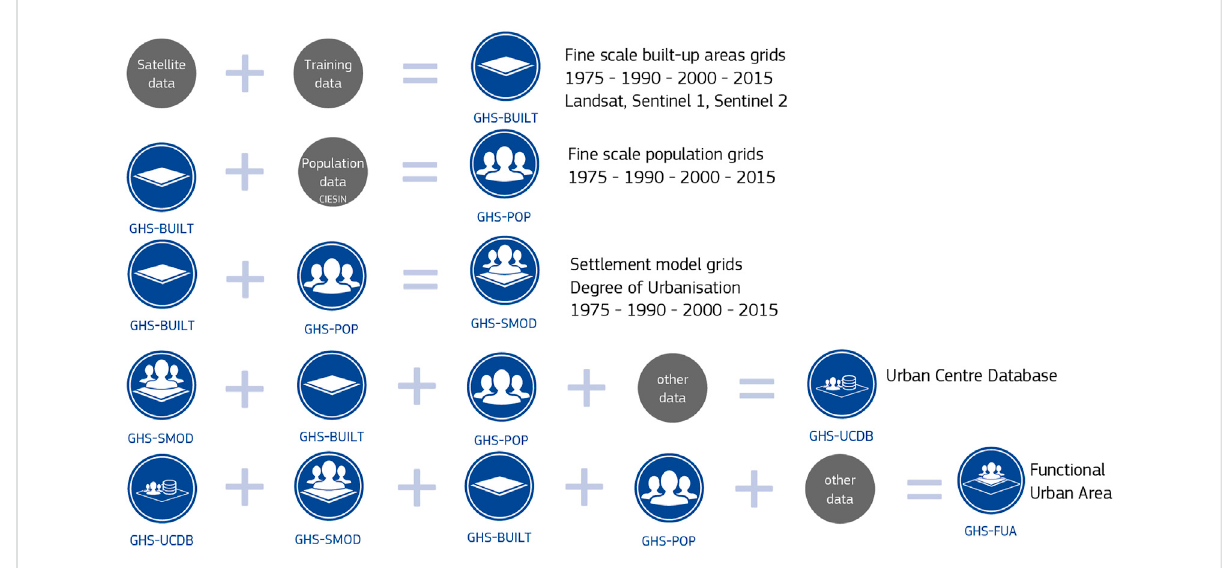
FIGURE 6 Hierarchicalanatomyofthekeyinformationcomponentsanddataprocessing/integrationusedtocreatetheGHS-UCDB.Startingfromsatellite imagery and a training set to produce the GHS-BUILT, combination of GHS-BUILT with demographic information to produce GHS-POP, combinationofGHS-BUILTandGHS-POPtoproducetheGHS-SMOD,andcombinationofthethreelayersaswellasothersatelliteinformationand otherdatasets,theGHS-UCDBhasbeencreatedandcombinationofthethreelayersaswellasothersatelliteinformationandotherdatasets,to create the